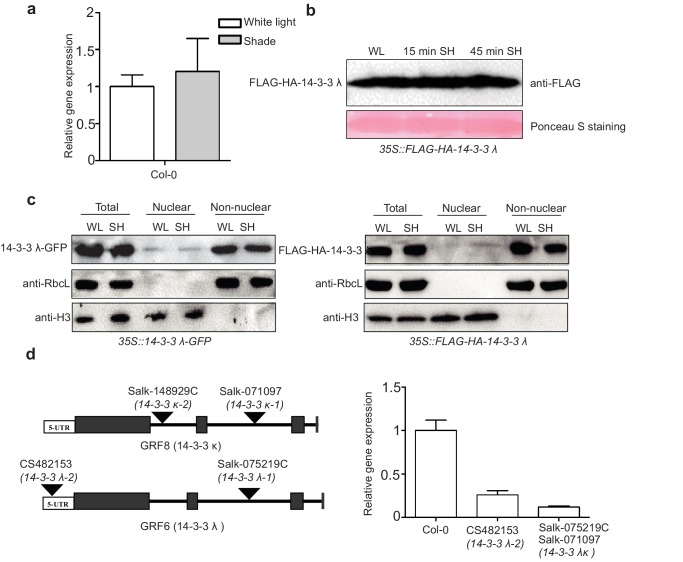
Effects of shade on the mRNA level, protein level and localization of 14-3-3 λ.(a) Relative gene expression of 14-3-3 λ in Col-0 grown under white light and shade. The seedlings were grown under white light for 5 days. Then, the seedlings were kept in white light or transferred to the shade for 1 hr for qRT-PCR. Means ± SEs from three independent biological replicates, after normalization to the internal control AT2G39960, are shown. (b) Immunoblot of FLAG-HA-14-3-3 λ using anti-FLAG in white-light-grown and the shade-treated 35S::FLAG-HA-14-3-3 λ transgenic seedlings. The seedlings were grown under white light for 5 days. Then, the seedlings were kept in white light or transferred to the shade for 15 min or 45 min for western blotting. Ponceau S staining was used to display the loading control for western blotting. (c) Shade effects on the localization of 14-3-3 λ-GFP and FLAG-HA-14-3-3 λ. Immunoblot of the 14-3-3 λ-GFP proteins using anti-GFP antibody and FLAG-HA-14-3-3 λ proteins using anti-FLAG in the total, nuclear and non-nuclear fractions from white-light- and shade-treated seedlings. (d) T-DNA insertion sites and 14-3-3 λ expression level in 14-3-3 λ mutants used in Figure 6c.